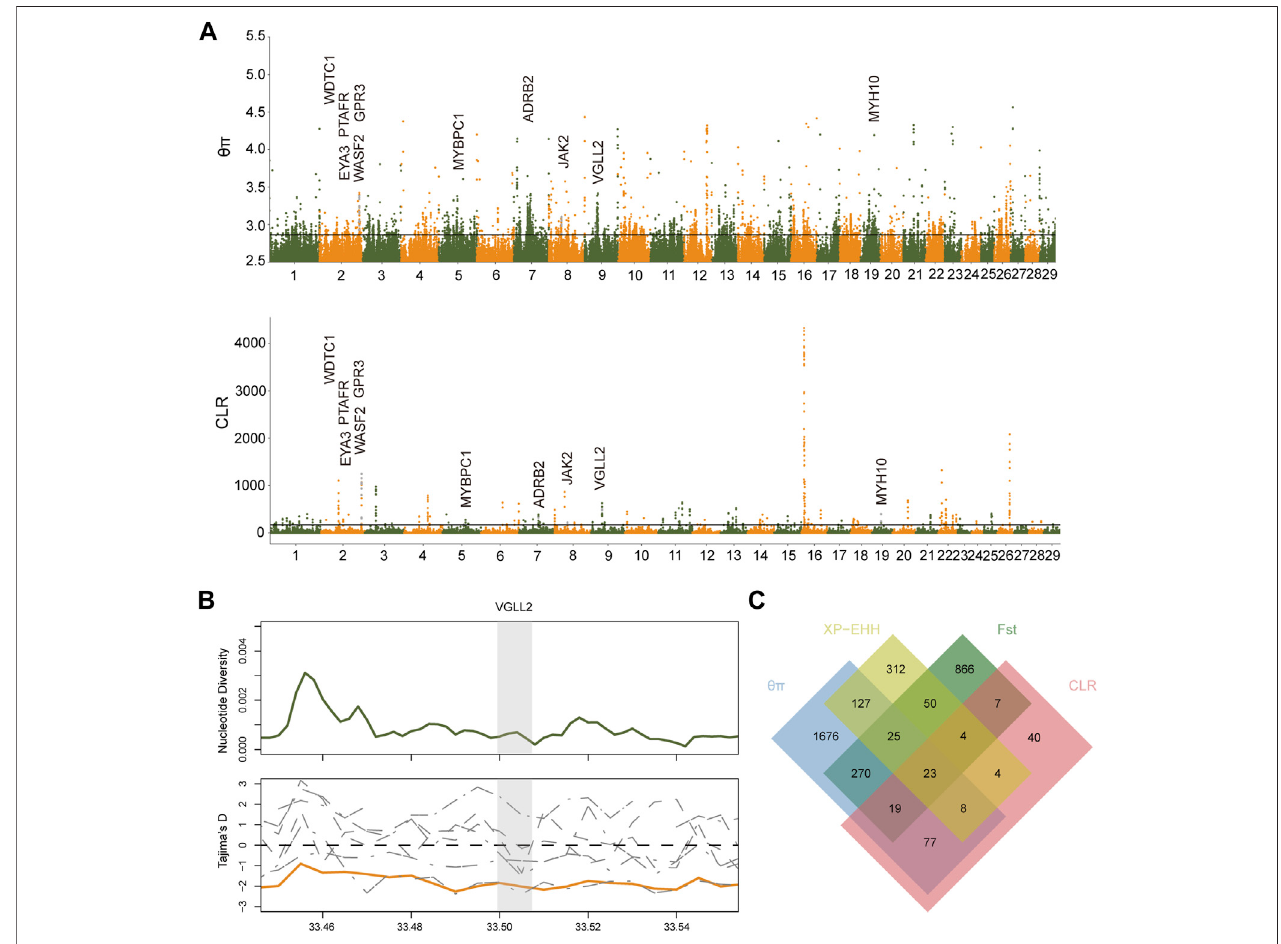
FIGURE3| ThesignaturesofpositiveselectioninXiangxi cattle. (A) Manhattan plot ofselectivesweepsby θπ and CLR methods (B) Nucleotide diversity of VGLL2 gene region in Xiangxi cattle. and Tajima ’ s D value in each group (orange line in Xiangxi cattle). (C) Number of candidate genes identi fi ed in Xiangxi cattle by the four methods ( θπ , CLR, F ST and XP-EHH) listed in each of the Venn diagram